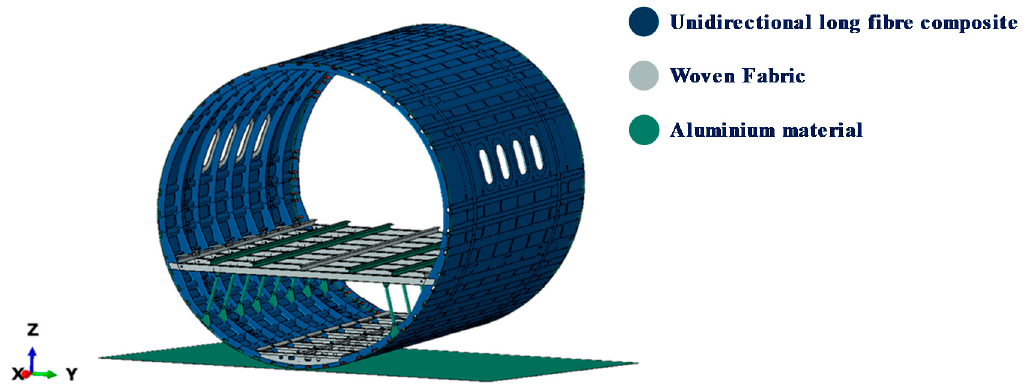
Figure 3. Material Figure 3. Material components. Figure 3. Material components. Table 2. UNIDIRECTIONAL (UD) material system properties. Table 2. UNIDIRECTIONAL (UD) material system properties.